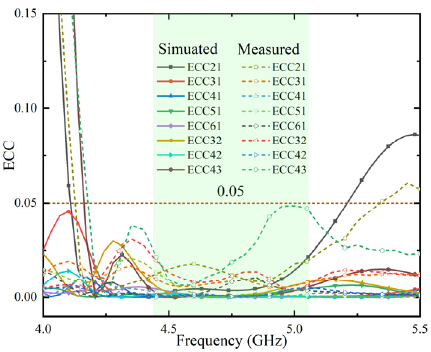
Figure 15. Simulated and measured of ECCs between some near antenna-element.